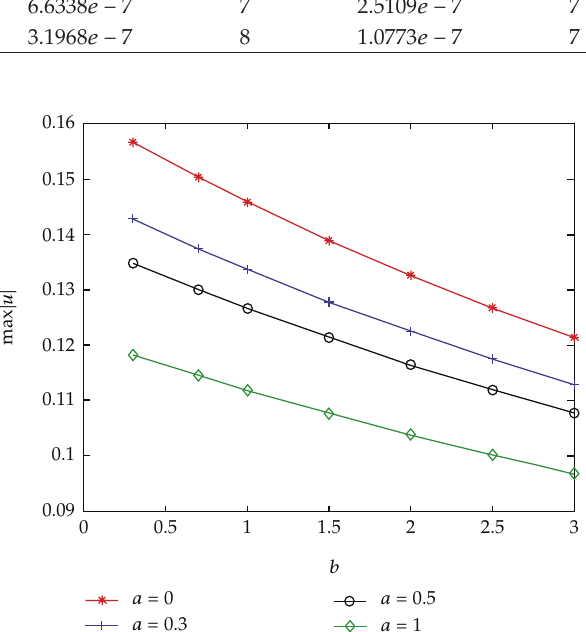
Figure 1: Variation of the value of u in the middle point with b for several values of a